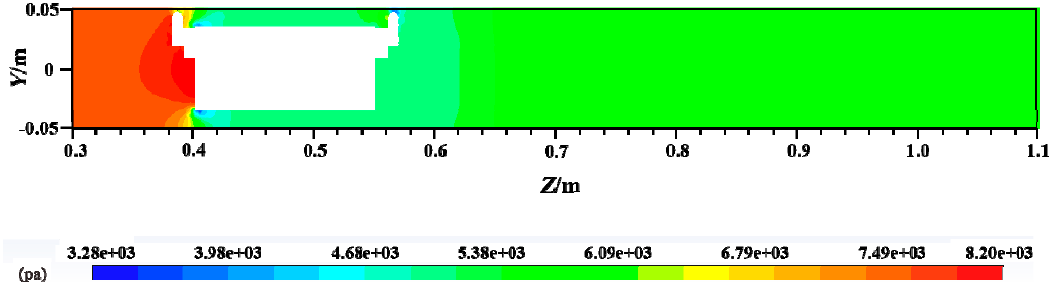
Figure 13. The pressure distribution cloud map of a single pipe vehicle in the YZ plane.